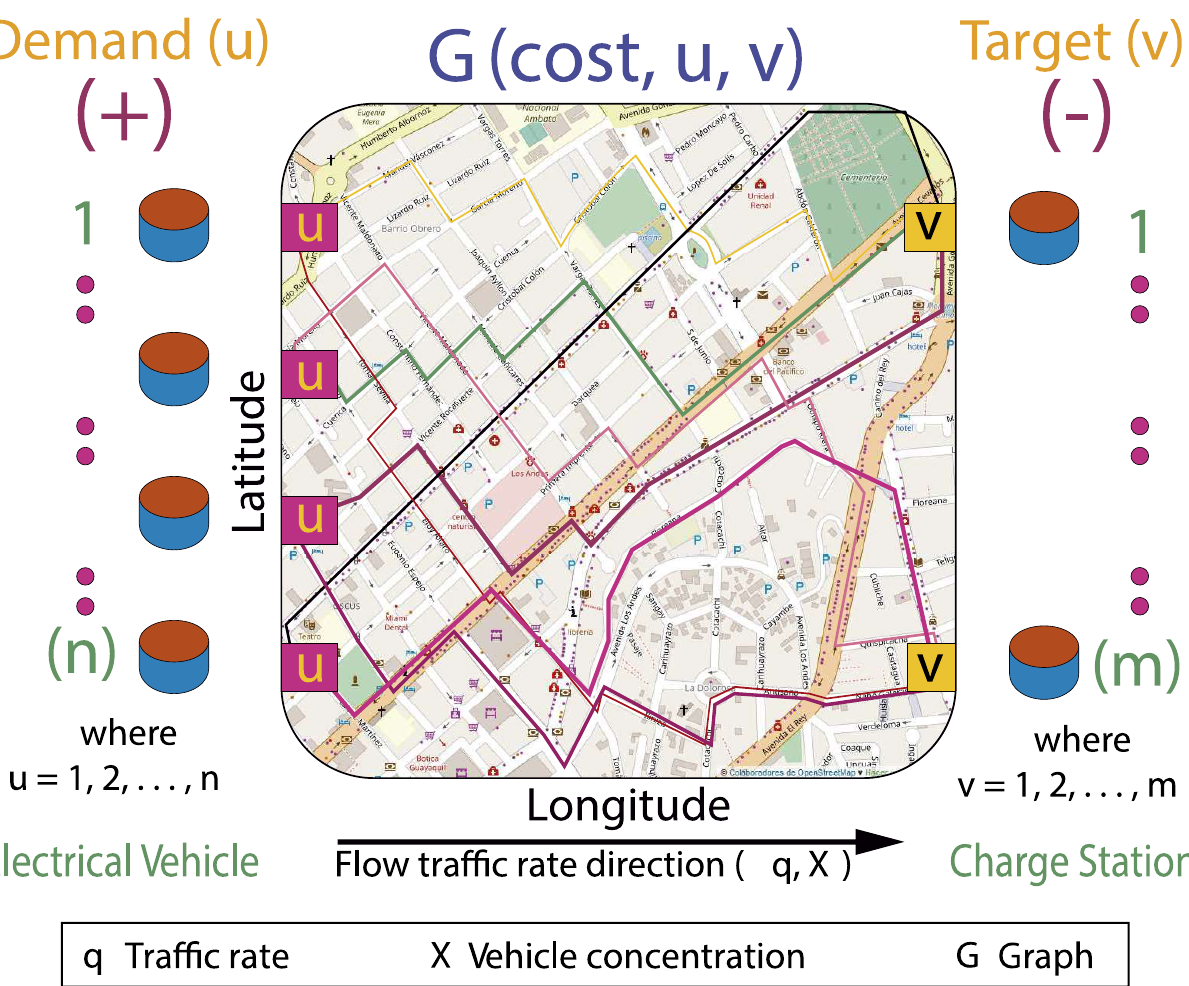
Figure 1. Applied network theory to solve the transport problem in